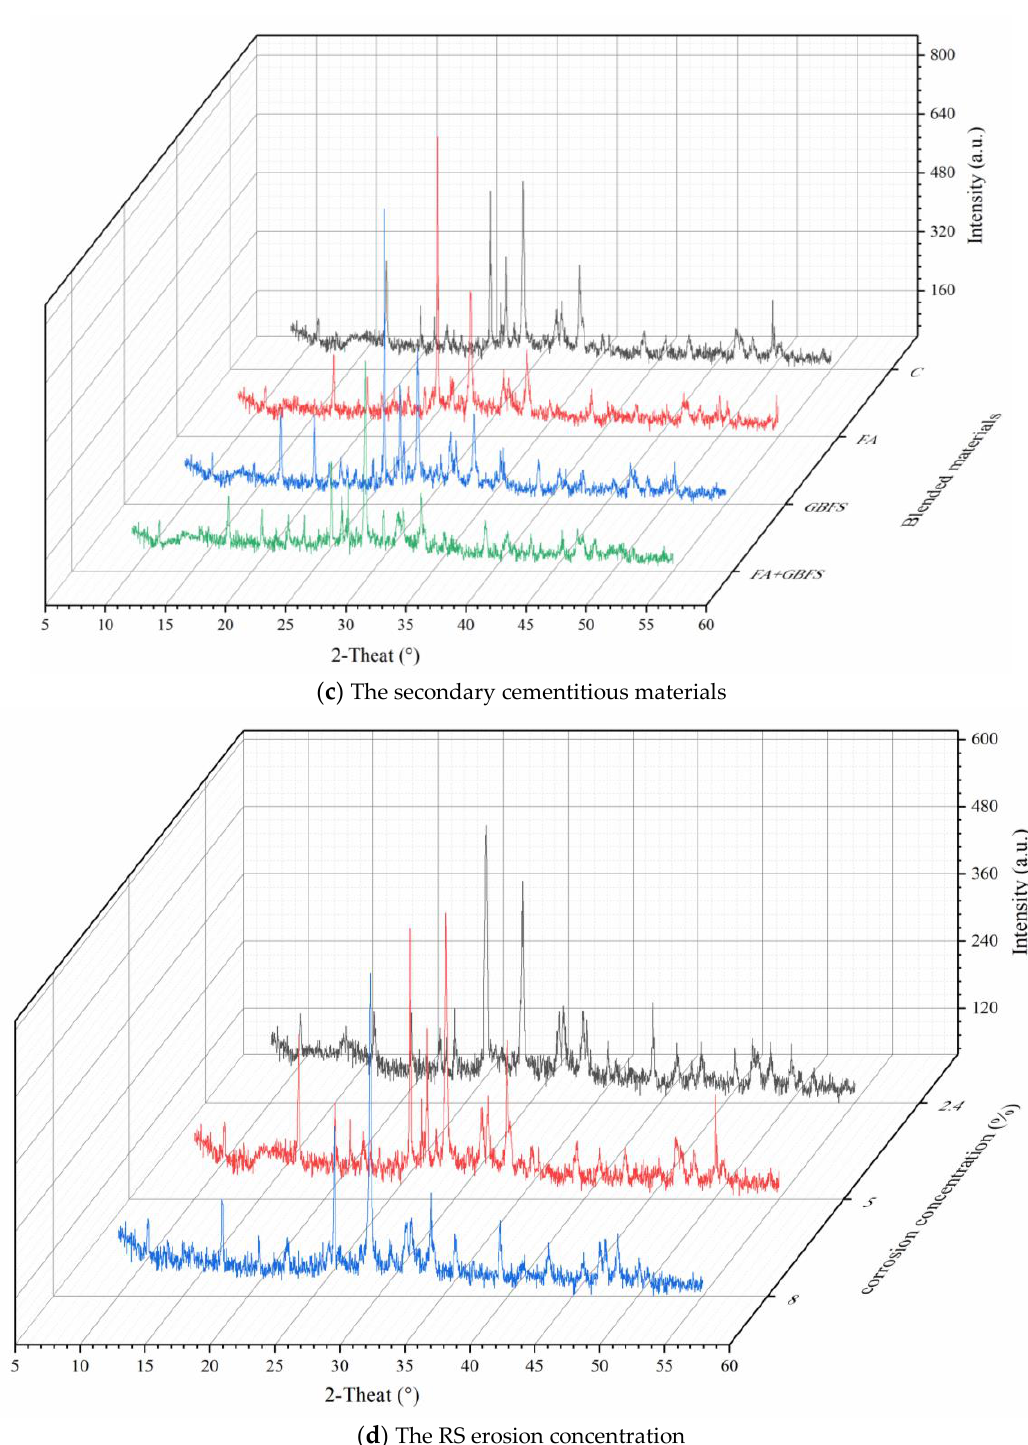
Figure 6. XRD pattern of the mortar: ( a ) The RS replacement percentage; ( b ) The W/C ratio; ( c ) The secondary cementitious materials; ( d ) The RS erosion concentration.